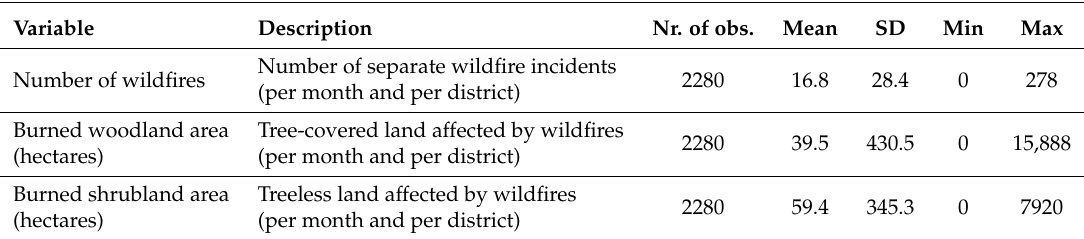
Table 1. Summary of wildfire data obtained from the Xunta de Galicia (regional government). Variable Description Nr. of